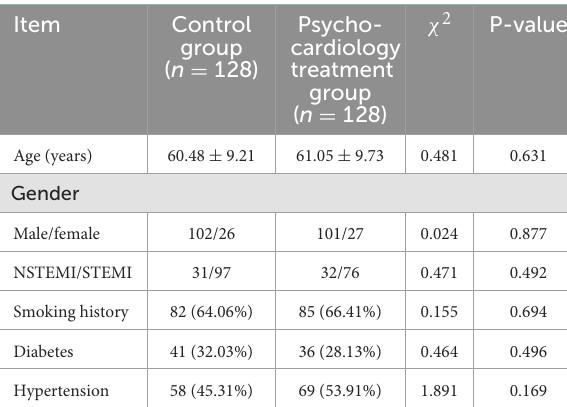
TABLE 1 Inter-group comparison of clinical data [ n ( x ± s